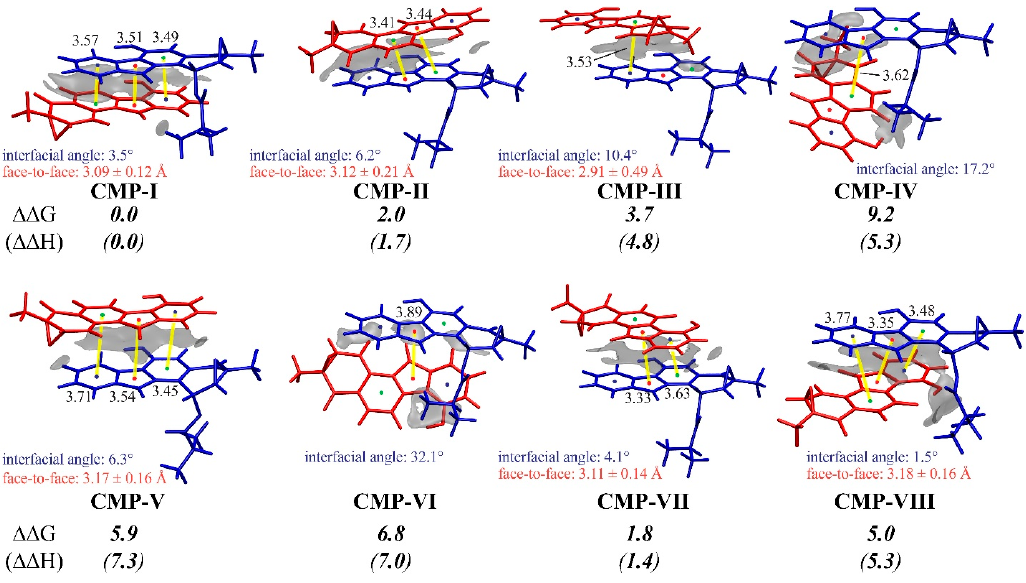
Figure 5. The complex structures of all pre-reaction states towards the eight possible diastereoisomers (INT). The weak intermolecular interactions were indicated as gray isosurfaces between p -QM (red) and FST 2 − (blue) by IGM. Relative free energies and enthalpies (in kcal / mol) were calculated to the CMP-I. As shown in Figures 3 and 5, pathways I to VIII were named by the rank of TScp energies, corresponding to the relative yields of final enantiomer products. CMP-I and V switched the up-and-down parallel position of the FST 2 − and p -QM molecules, toward the 1-(R)-10 ′ -(S) and 1-(S)-10 ′ -(R) configuration of diastereoisomer products. Similarly, CMP-II / VI , III / VIII , and IV / VII are paired 6-5-6 parallels. CMP-I , III , V , and VIII were related to the C10 ′ attacking, whereas others were related to the C8 ′ . The lowest energy CMP-I and TScp-I were connected in the dominant pathway I to the major product Prod-I&III . In general, the π – π stacking effect plays a central role in the complexations, and the stability is related to how the two